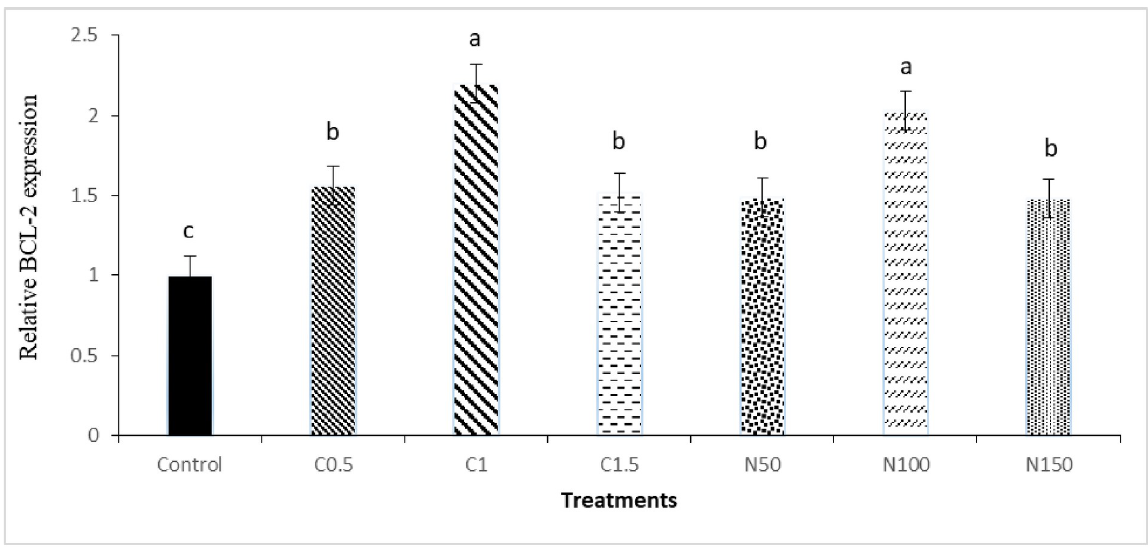
extender with 1.5 mM crocin), N50 (Beltsville extender with 50 μ M naringenin), N100 (Beltsville extender with 100 μ M naringenin), N150 (Beltsville extender with 150 μ M naringenin).